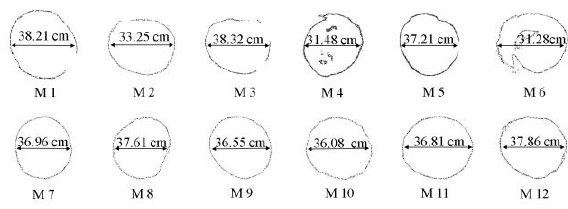
Figure 3. Illustration of the cross-section at 1.3 m of the same individual tree with DBH = 34.38 cm of multiple-tree mode (Methods 1-6) and single-tree mode (Method 7-12).